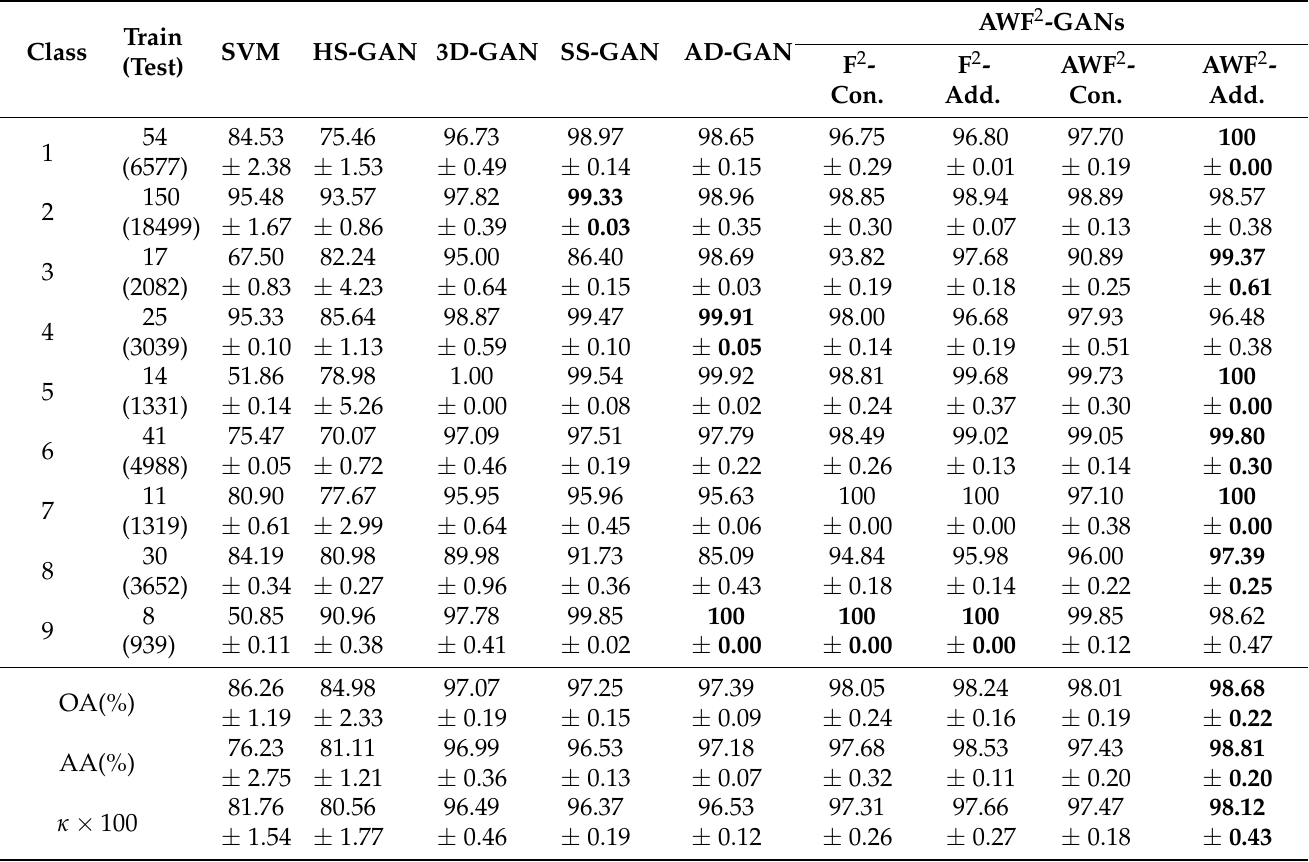
Table 5. The overall accuracy (OA), average accuracy (AA), kappa coefficient ( κ ), and individual class accuracies for the UP dataset with 350 labeled and unlabeled samples for training. The best results are highlighted in bold